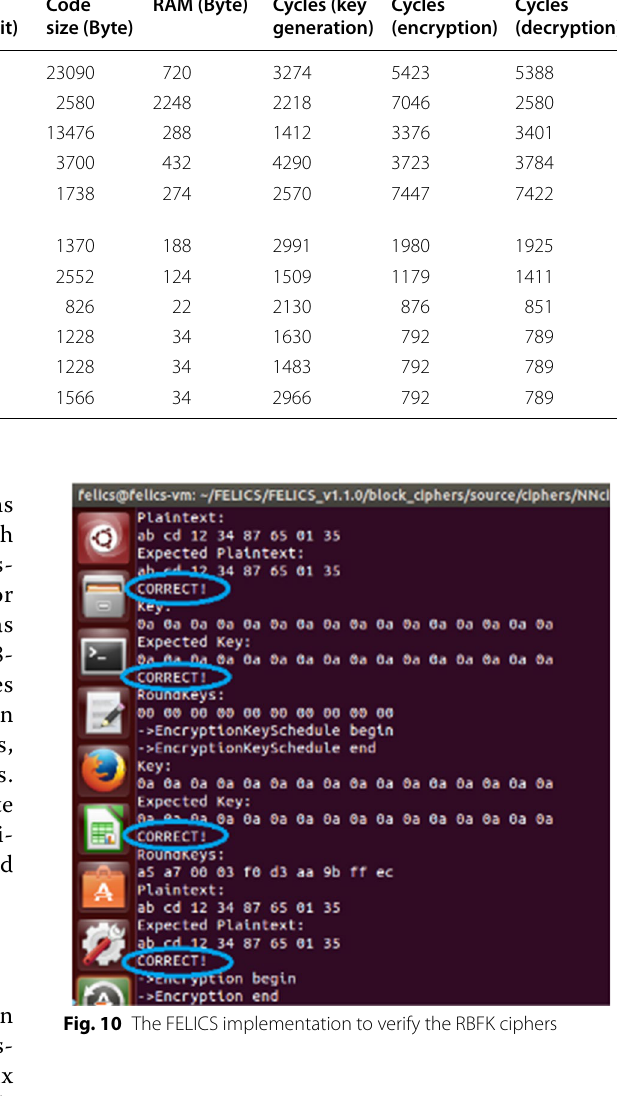
Table 4 Comparison of execution cycles taken by the different ciphers on AVR architecture CIPHER Device Block size (bit)